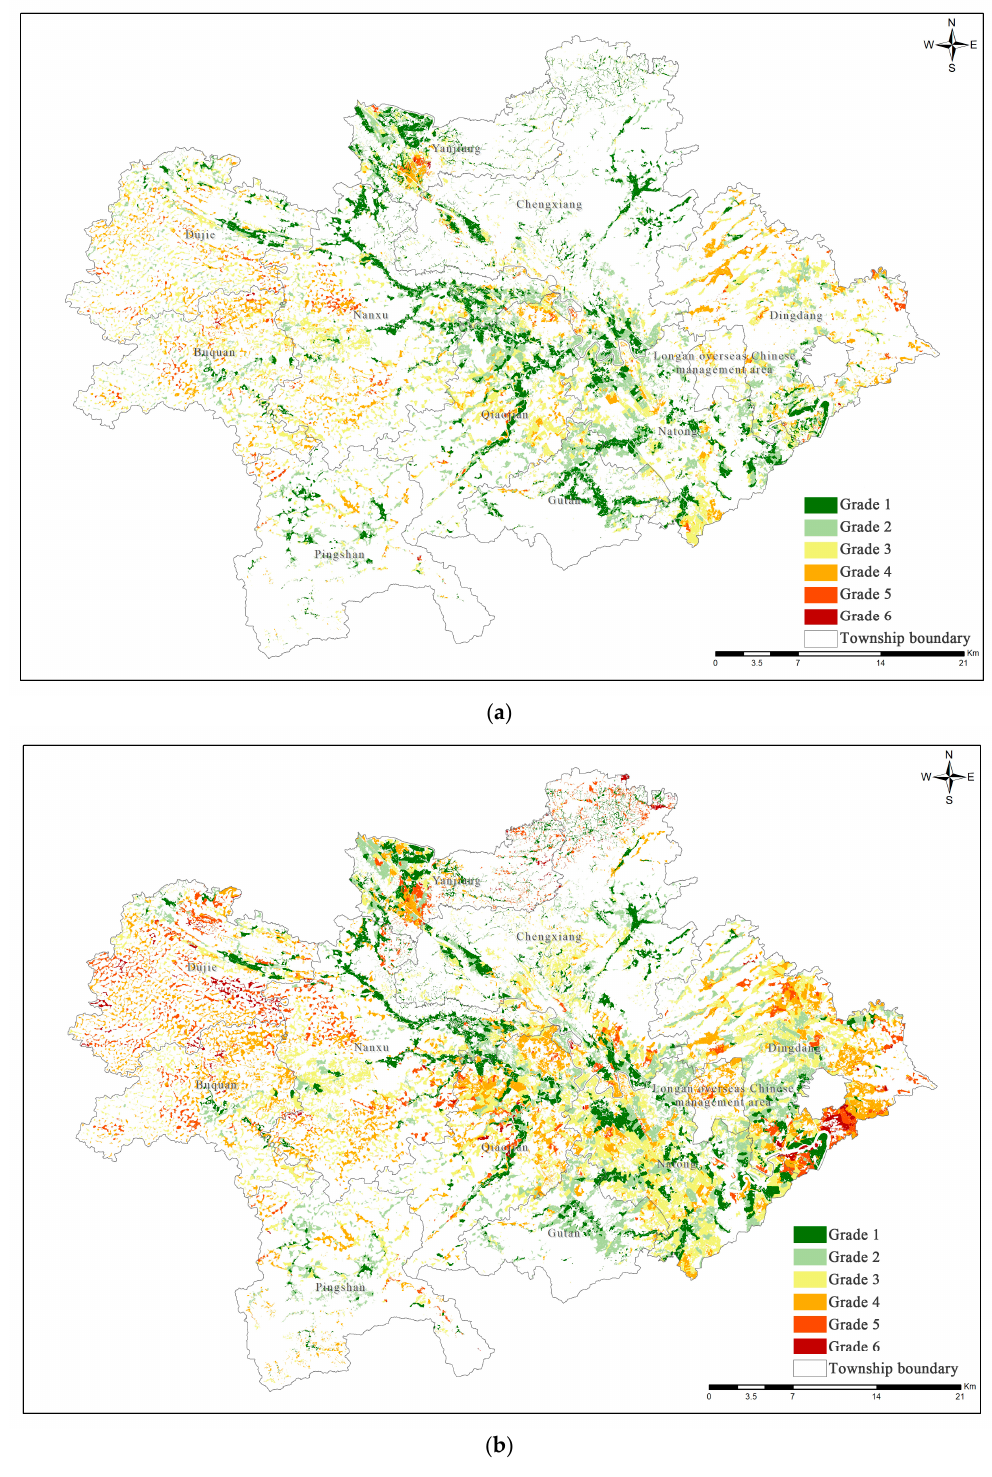
Figure 7. ( a ) Quality grading map of cultivated land 2010; ( b ) Quality grading map of cultivated land 2020.